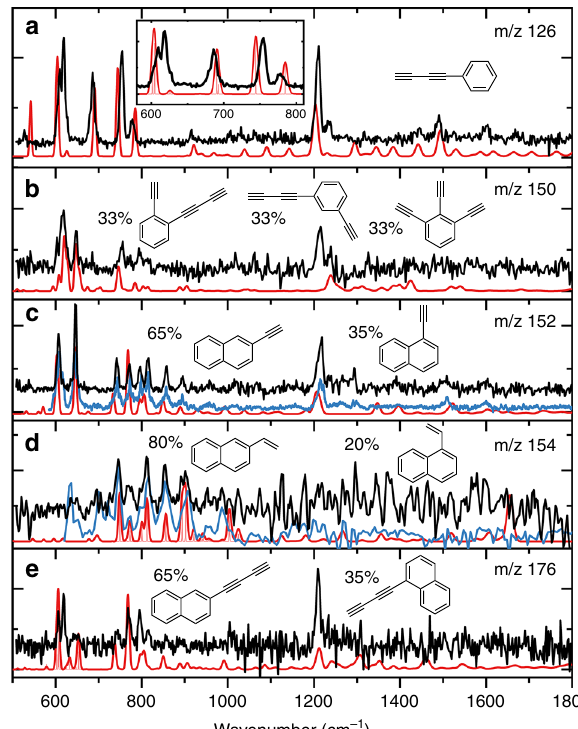
Fig. 2 Mass selected IR spectra (black) of discharge products with the assigned theoretical IR spectra (red). The mass channels shown are m / z = a 126, b 150, c 152, d 154, and e 176 and are recorded using 36616cm − 1 UV photon energy. The molecules assigned are a buta-1,3-diyn-1-ylbenzene (diacetylenebenzene); b 1-(buta-1,3-diyn-1-yl)-2-ethynylbenzene, 1-(buta- 1,3-diyn-1-yl)-3-ethynylbenzene, and 1,2,3-triethynylbenzene; c 1- and 2- ethynylnaphthalene (1EN and 2EN); d 1- and 2-ethenylnaphthalene; and e 1- and 2-(buta-1,3-diyn-1-yl)naphthalene. For b – e , two or more theoretical IR spectra of structural isomers are used to fi t the experiment allowing for the determination of the ratio between the formed isomers (individual calculated spectra can be found in Supplementary Figs. 2 – 5). The blue trace in the m / z 152 box corresponds to an FT-IR reference spectrum taken from 1EN and 2EN combined with a 1:2 ratio, respectively. The blue trace in the m / z 154 box corresponds to an FT-IR reference spectrum taken from 1- and 2-vinylnaphthalene combined with a 1:4 ratio, respectively. The light red traces correspond to stick spectra to display adjacent